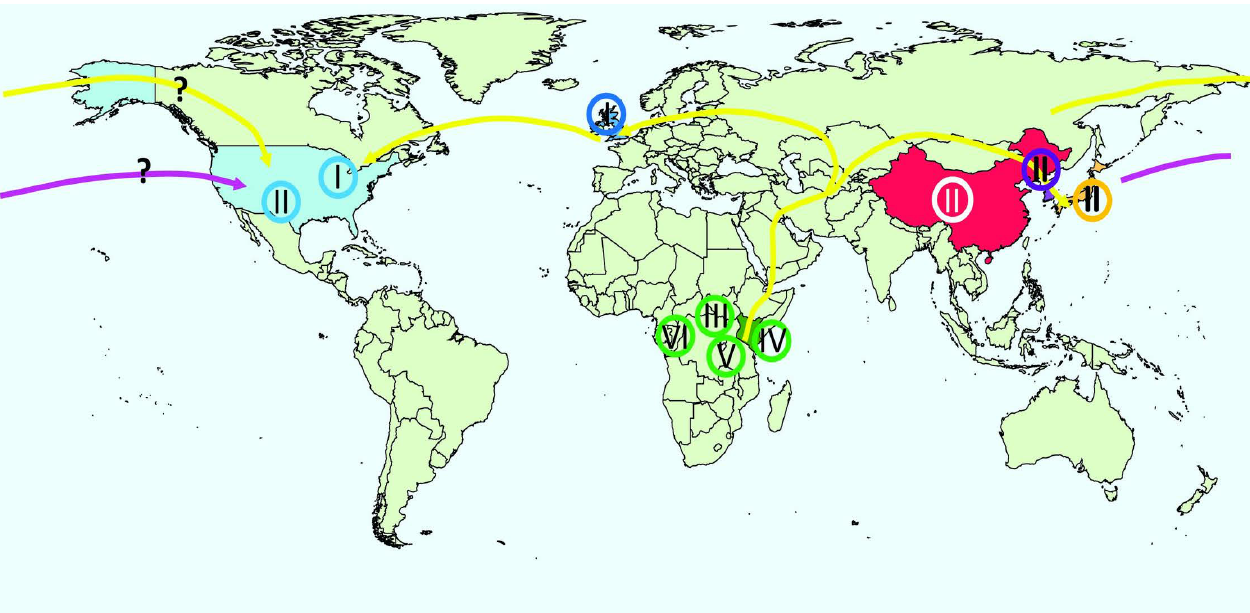
Figure 4. World map featuring the geographic location of the 6 HSV-1 clades with respect to human migration. The phylogenetic data supports the ‘‘out of Africa model’’ of human migration with HSV-1 traveling and diversifying with its human host. Each clade is depicted by a roman numeral inside a circle. Land migration is depicted by yellow lines and air/sea migration is shown by the pink line. The countries of origin for the strains in the current study are China (red), Japan (orange), Kenya (dark green), South Korea (purple), UK (dark blue), and USA (light blue). The map was generated using R (version 3.4.2, "maps" package).